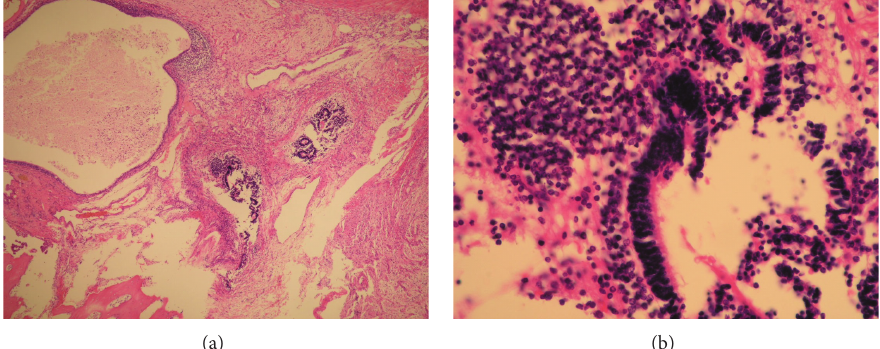
Figure 4: Pathologic findings of right ovary. Immature neuroepithelium seen with hair follicles and sebaceous glands. (a) H&E × 40. (b) H&E ×